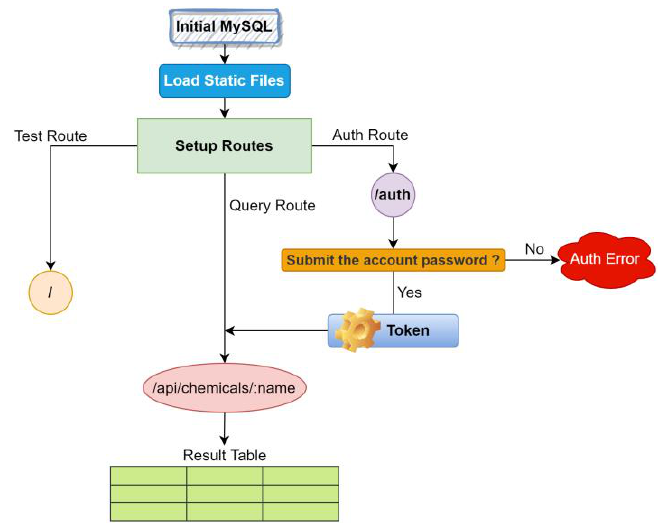
Figure 7. The workflow of querying hazardous